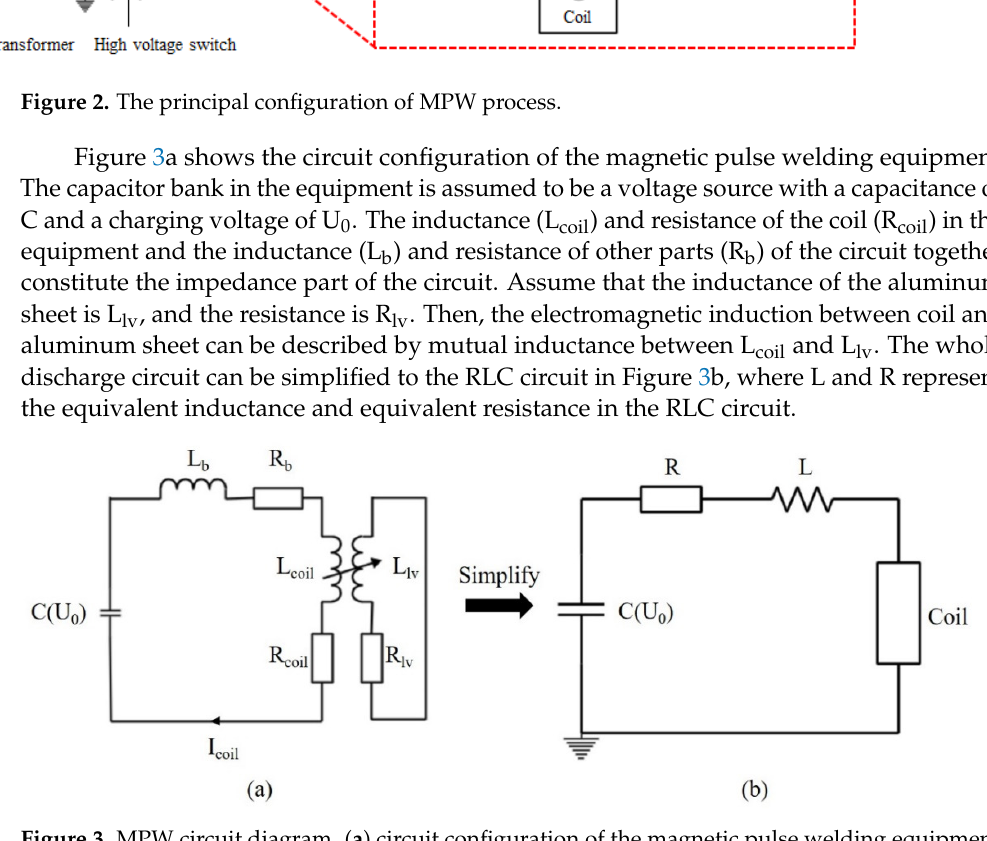
Figure 3. MPW circuit diagram. ( a ) circuit configuration of the magnetic pulse welding equipment; ( b ) simplify RLC circuit.